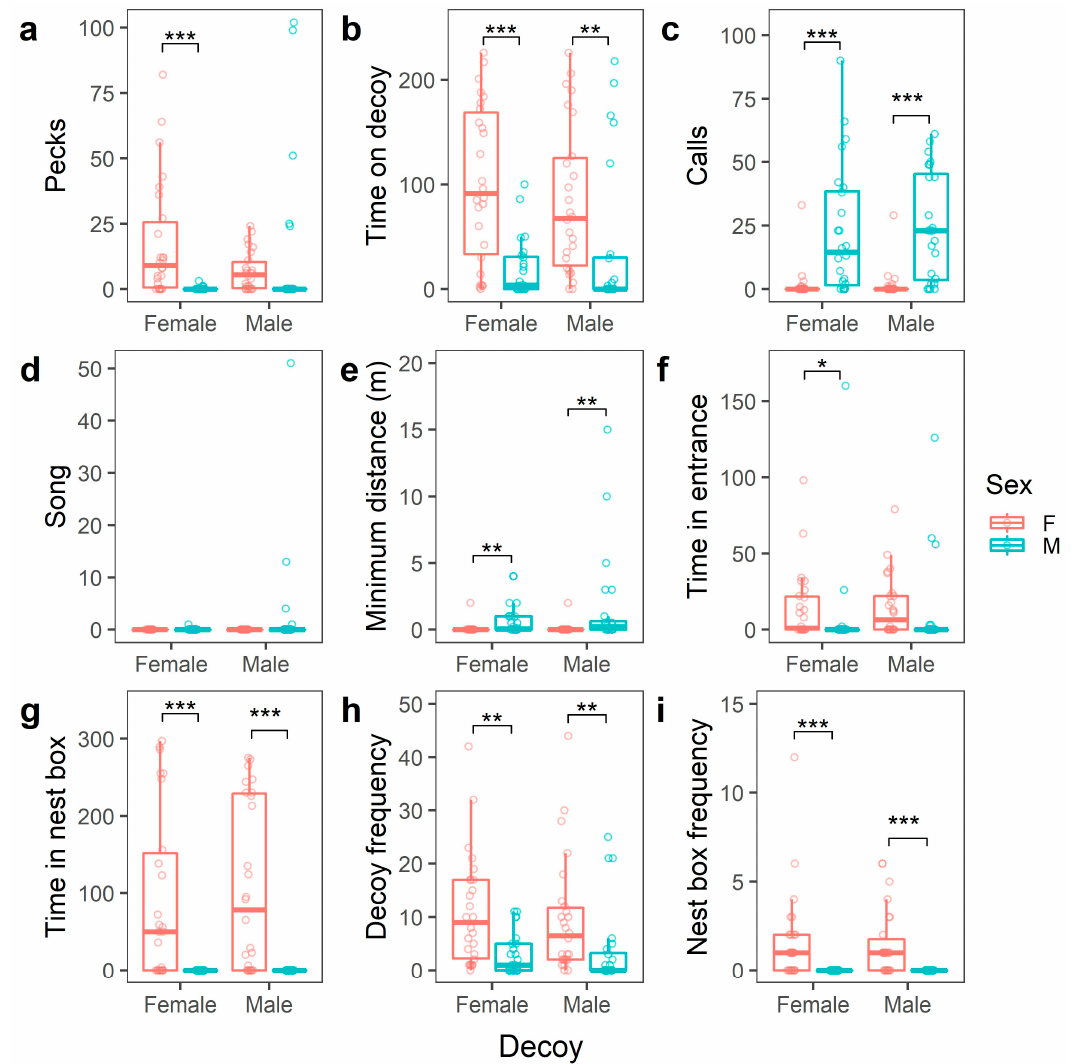
Figure 4. Comparison of behavioural variables between the sexes (N Female = 26 in red; N Male = 24 in blue) of the tested birds and the sexes of the decoys. Asterisks indicate level of statistical significance: * p ≤ 0.05, ** p ≤ 0.01, *** p ≤ 0.001. Behavioural variables: The number of pecks ( a ); Time spent on the decoy ( b ); The number of calls ( c ); The number of song phrases ( d ); The minimum distance to the decoy ( e ); Time spent in front of the nest-box entrance ( f ); The time spend in the nest box ( g ); The number of times perching on the decoy ( h ); The number of times entering the nest box ( i ).